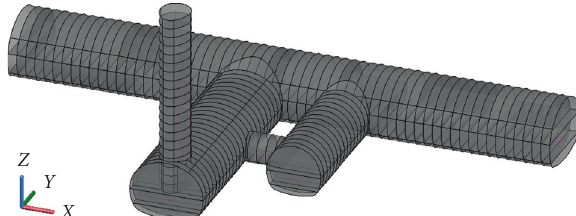
Figure 10: Model of a tunnel presented as solid cut on individual excavation steps.